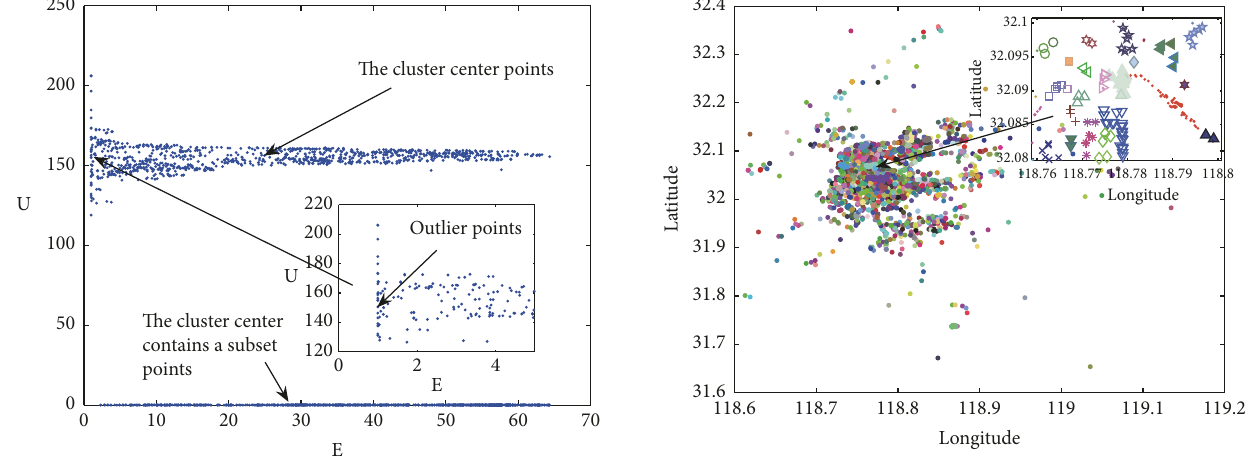
Figure 3: Data field energy and point spacing distribution diagram of passenger taxi to get-off point.